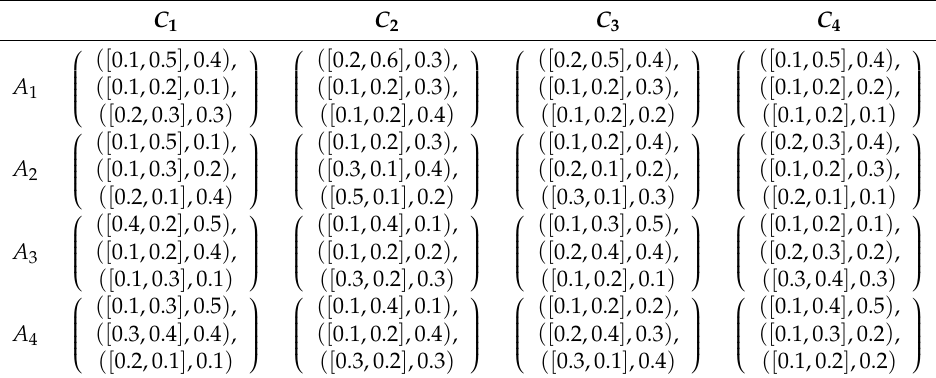
Table 2. Second decision-maker data.